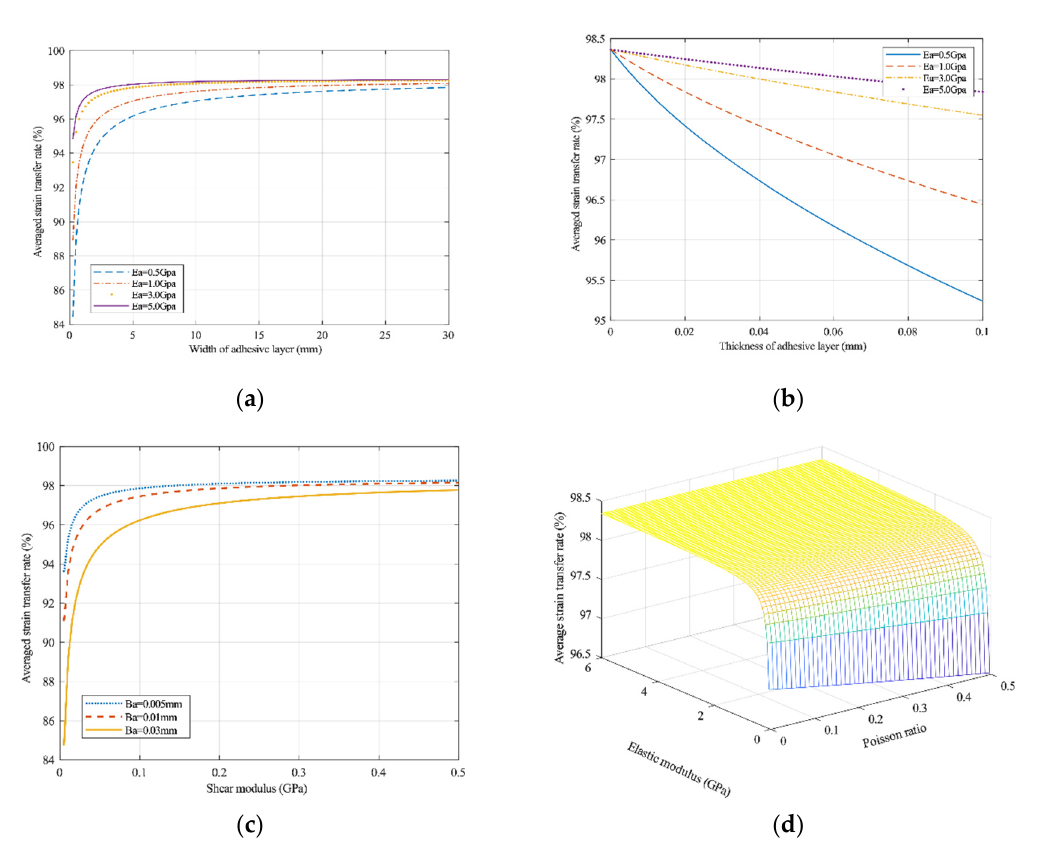
Figure 8. Influence of the adhesive layer parameters on the variable transfer coefficient: ( a ) width of the adhesive layer, ( b ) thickness of the adhesive layer, ( c ) shear modulus of the adhesive layer, and ( d ) bond ratio [22] .